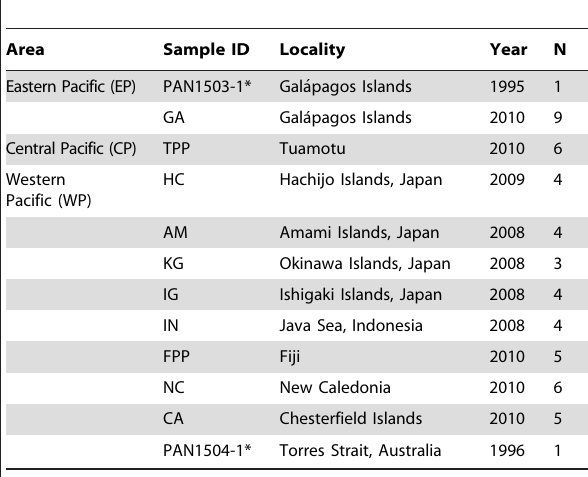
*Muscle tissues were provided by Michael J. Childres and Margaret B. Ptacek.